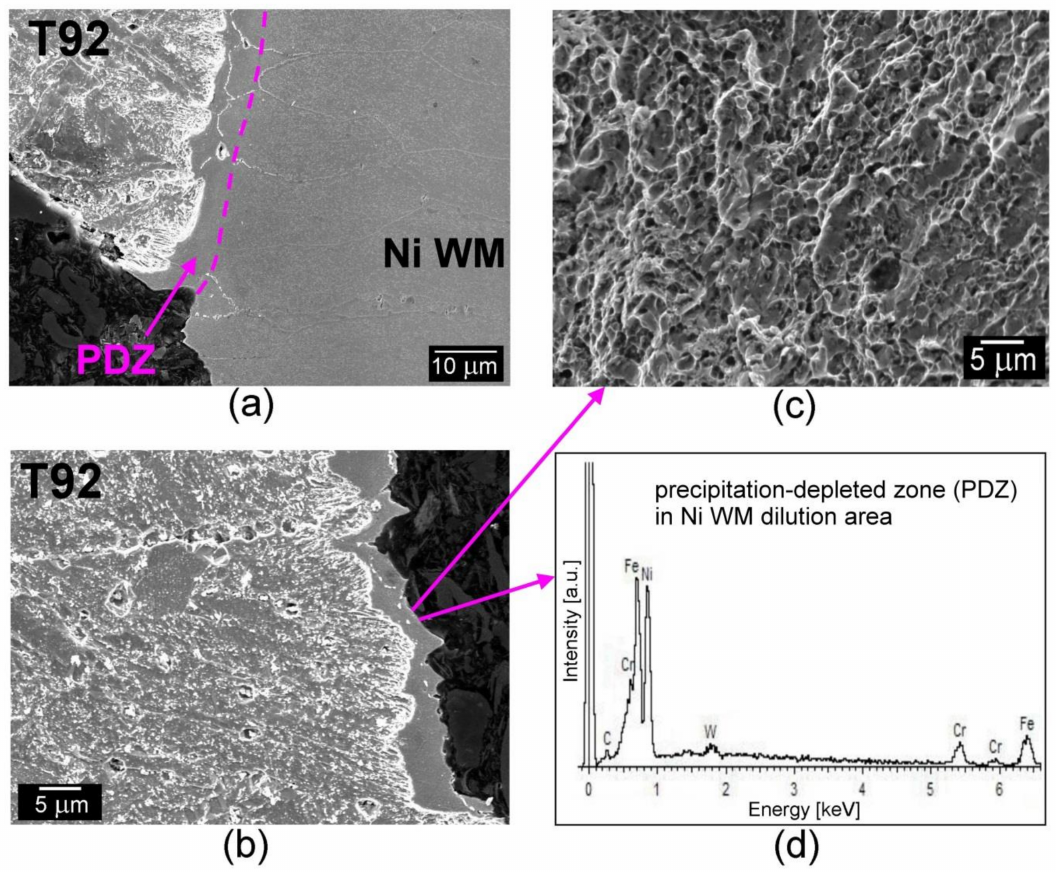
Figure 14. Fracture analysis of the failure occurred in vicinity of T92 BM/Ni WM interface after room-temperature tensile test of T92/TP316H dissimilar weldment in “QT PWHT + 620 ◦ C/2500 h” condition: Fracture path and microstructure beneath the failure ( a , b ); Fracture surface showing dimple and intensive shear areas ( c ); Typical EDX spectrum of Ni WM dilution area at the fracture location ( d